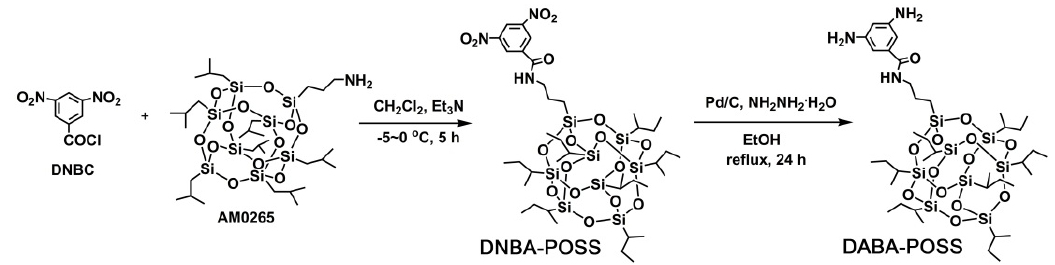
Figure 1. Synthesis of N -[(heptaisobutyl-POSS)propyl]-3,5-diaminobenzamide (DABA-POSS) diamine.